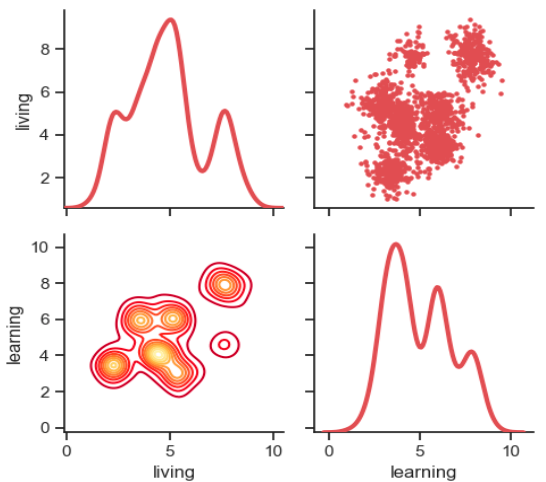
Figure 6. The scatter plot matrix of S3.